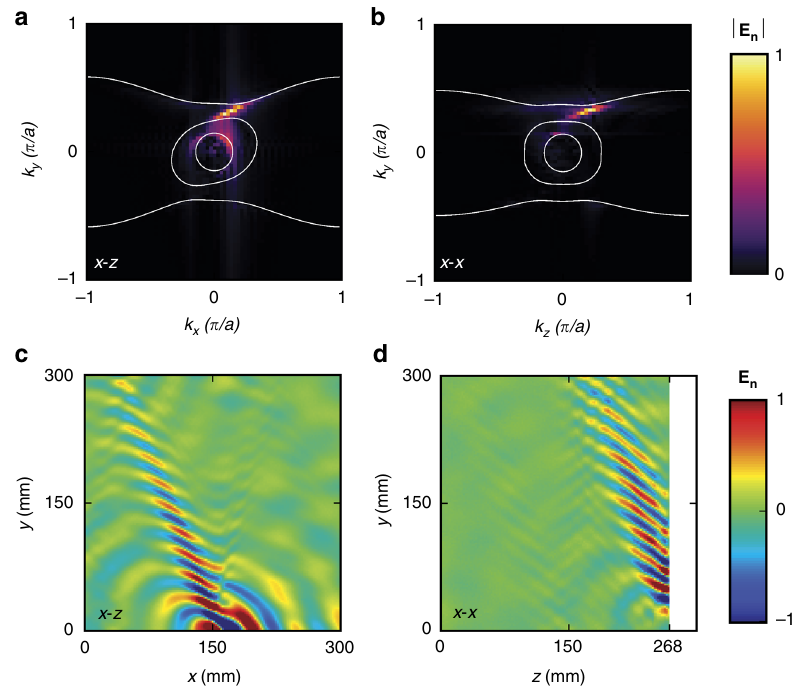
Fig. 4 Momentum and real space representations of topological surface-state arcs. a , c Top surface scan taken with the x (polarized source) − z (polarized probe) con fi guration at 5.46 GHz. c Real-space instantaneous fi eld. a Momentum space amplitude fi eld after Fourier transformation of c . b , d Side surface scan with respect of x (polarized source) − x (polarized probe) con fi guration at 5.46 GHz. b , d Same plot as a and c , but on the side surface. The source position for the side surface scan is on the top surface with coordinate ( x = 10 mm, y = 0 mm, and z = 268mm). Solid circles indicate the light cone, and are far away from topological surface-state arcs, thus the surface wave is well localized. The normal components of the electric fi elds in a – d are normalized to the same reference values, respectively (from CST Microwave Studio) in terms of the TSA and their locations in momentum space, as shown in Fig. 3. The deviations between the measurements and calculations regarding the exact shape and size of each TSA may arise from the sample fabrication errors and misalignment of layer stacking. Additional comparisons between experiment and simulation results at different frequencies are given in Supplementary Fig. 3.